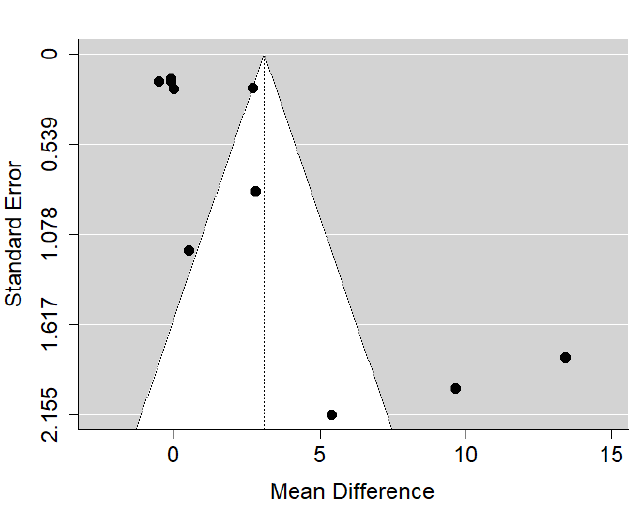
Figure 17. Funnel plot of SNA values for the comparison of CPO patients of different age [20,23,27,28,30,32]. ANB